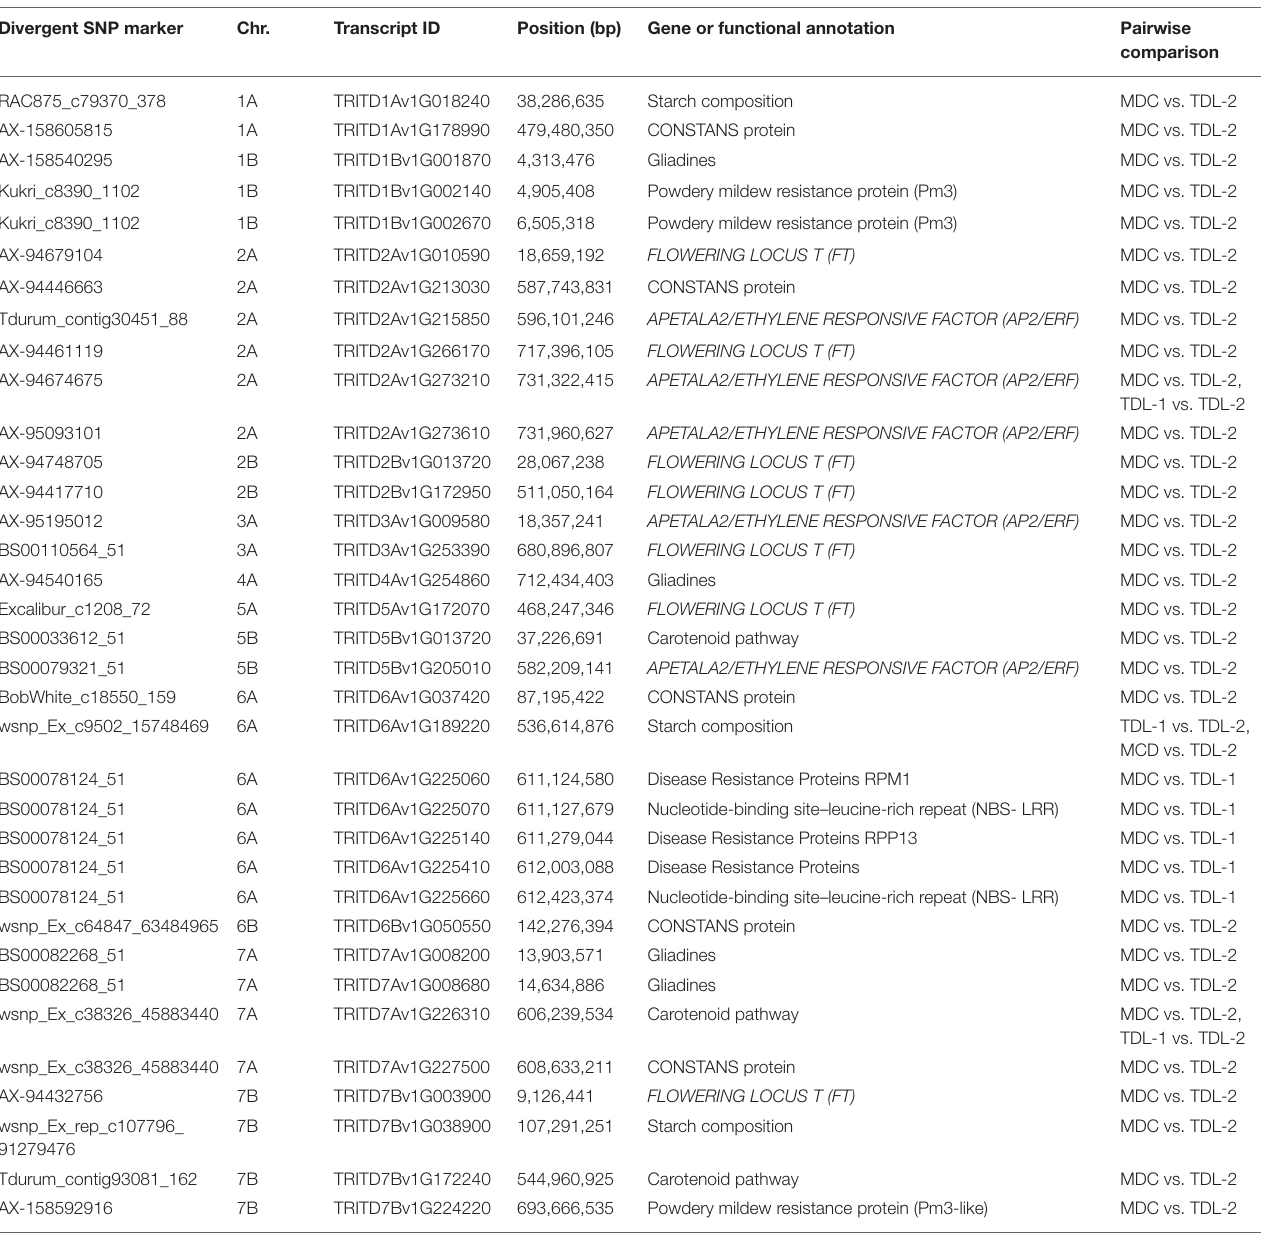
TABLE 3 | Core set of candidate genes detected using divergent SNP loci between the modern durum cultivars (MDC), Tunisian durum landraces group 1 (TDL-1) and group 2 (TDL-2) using F ST > 0.60. Divergent SNP marker Chr. Gene or functional annotation Pairwise